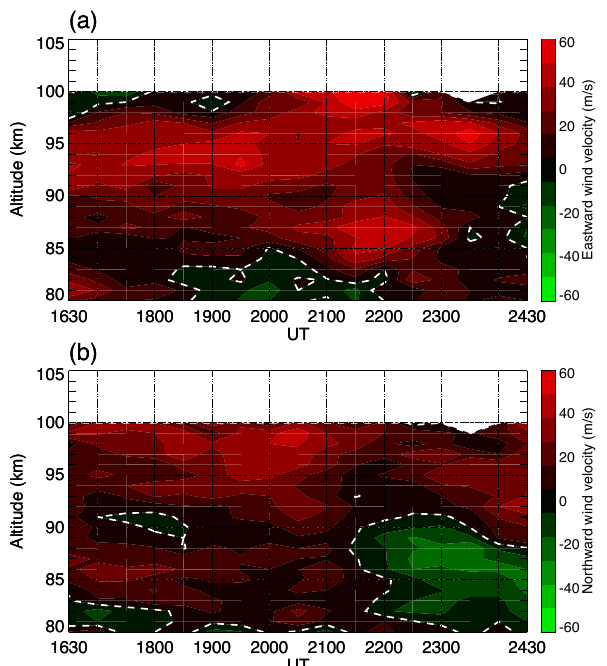
Figure 3. The eastward (a) and northward (b) wind velocity ob- tained by meteor radar from 80 to 100km from 16:30 to 24:30UT on 29 October 2010. White dashed lines indicate zero wind velocity.